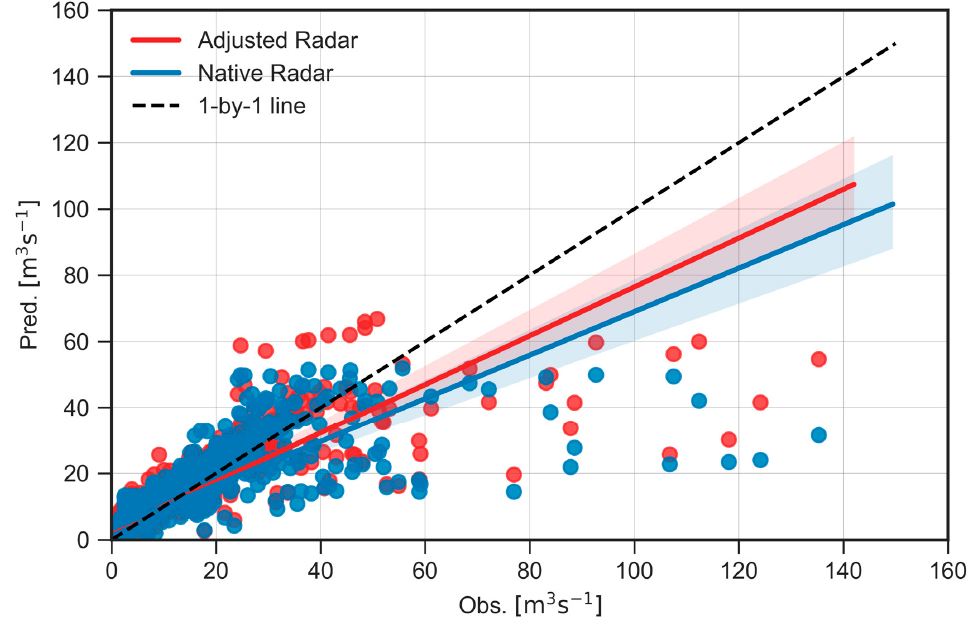
Figure 8. Influence of the use of data type (adjusted or native—reflectivity—radar data) in the discharge forecasting models. The bisector line is showed in dotted black; the continuous lines denotes the linear regressions and the shadow areas represent the 95% confidence interval band of each regression respectively.